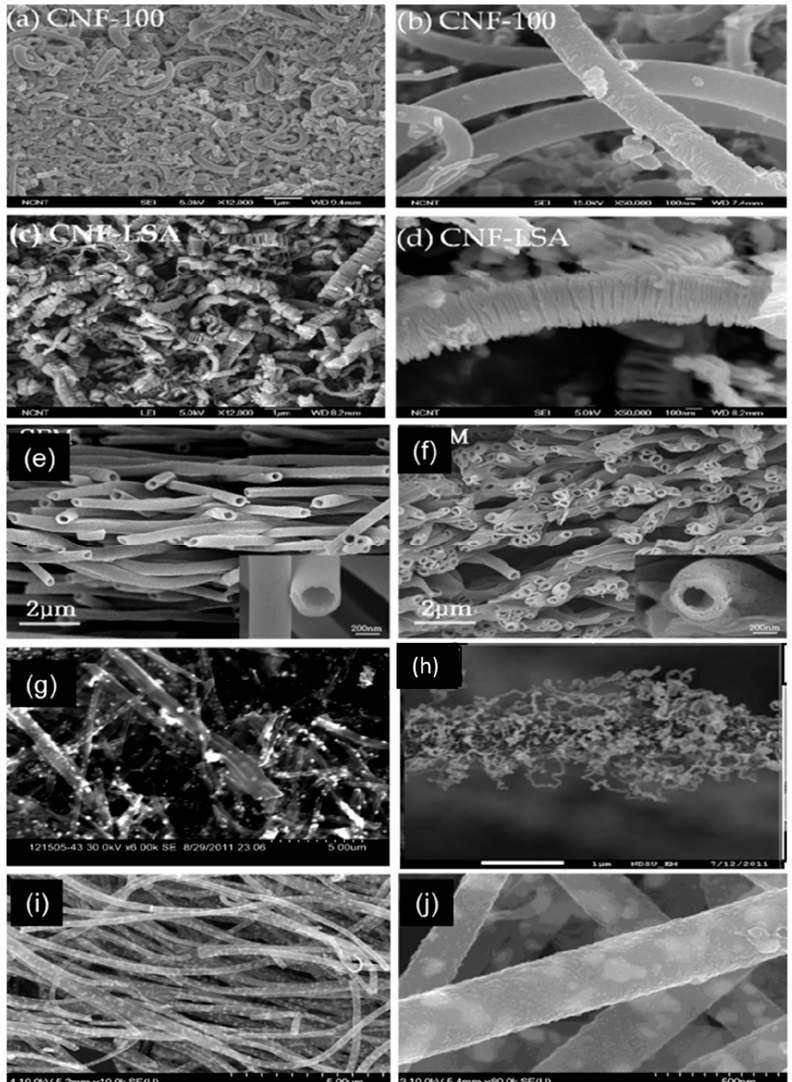
Figure 13. SEM surface morphology of carbon nanofiber (CNF) powders and films deposited on FTO glass substrates: ( a ) The CNF-100 film, ( b ) magnified image of the CNF-100 powder, ( c ) the antler carbon-nanofiber (CNF-LSA) film, and ( d ) magnified image of the CNF-LSA powder. Reprinted with permission from Reference [89]. ( e ) Cross-sectional SEM image of hollow activated carbon nanofibers (HACNF) and photocurrent-voltage curves (Figure 14) for HACNF, meso-HACNF1, and ( f ) meso-HACNF2. Reprinted with permission from Reference [57]. ( g ) Hybrid CNF-Pt. Reprinted with permission from Reference [42], ( h )